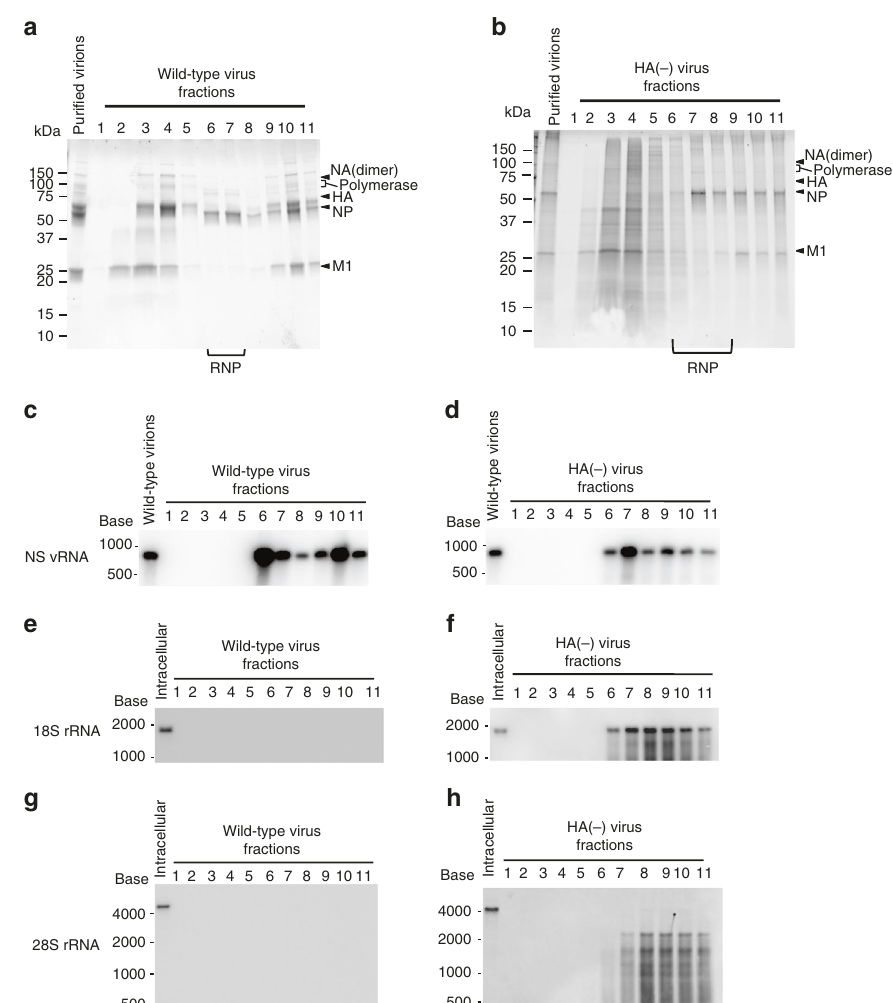
Fig. 4 Fractionation of disrupted wild-type and HA( − ) virions by glycerol density gradient centrifugation. Puri fi ed wild-type virus ( a , c , e , g ) or HA( − ) virus ( b , d , f , h ) was disrupted by TritonX-100. The samples were subjected to 20 – 60% glycerol density gradient centrifugation. Eleven fractions were collected from the top of the gradient and numbered in ascending order from the top of the gradient to the bottom. a , b Each fraction was subjected to SDS-PAGE, followed by Oriole staining. c – h The presence of NS vRNA ( c , d ) 18S rRNA ( e , f ), and 28S rRNA ( g , h ) was examined by northern blot analysis using a digoxigenin-labeled oligonucleotide probe that bound to NS vRNA, 18S rRNA, or 28S rRNA (nucleotide positions 1081 – 4679). The numbers at the top of the panel denote fraction